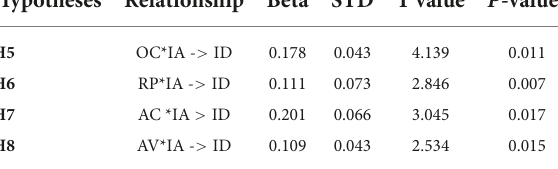
TABLE 5 Structural model assessment (moderation